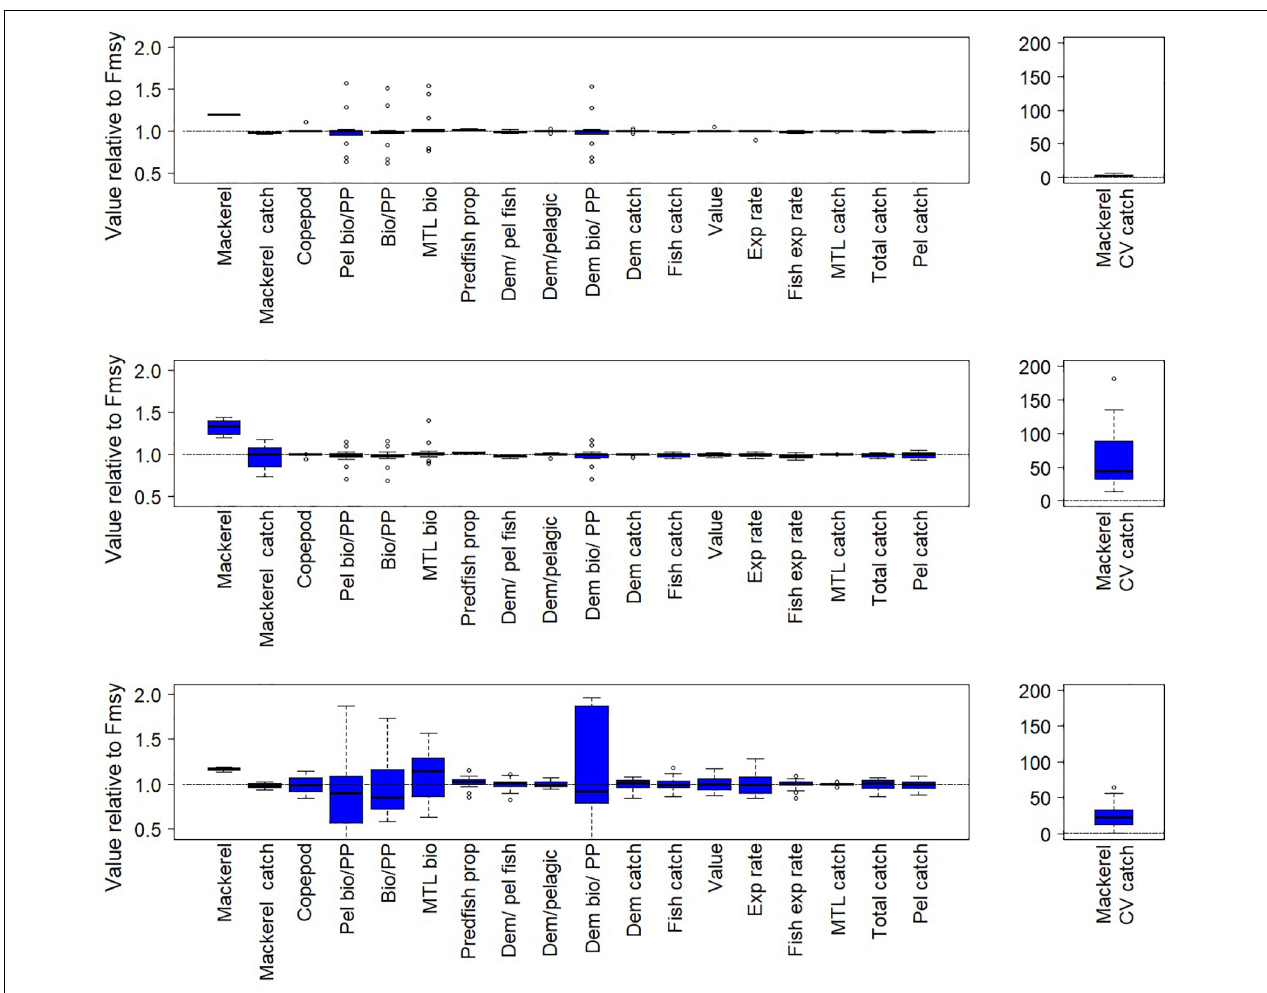
FIGURE 6 | Fishery and ecological metrics as in Figure 5 , but for the Nordic and Barents Seas, with mackerel as target fish. Each of the pairs of simulations here is forced with a different time series of copepod biomass.